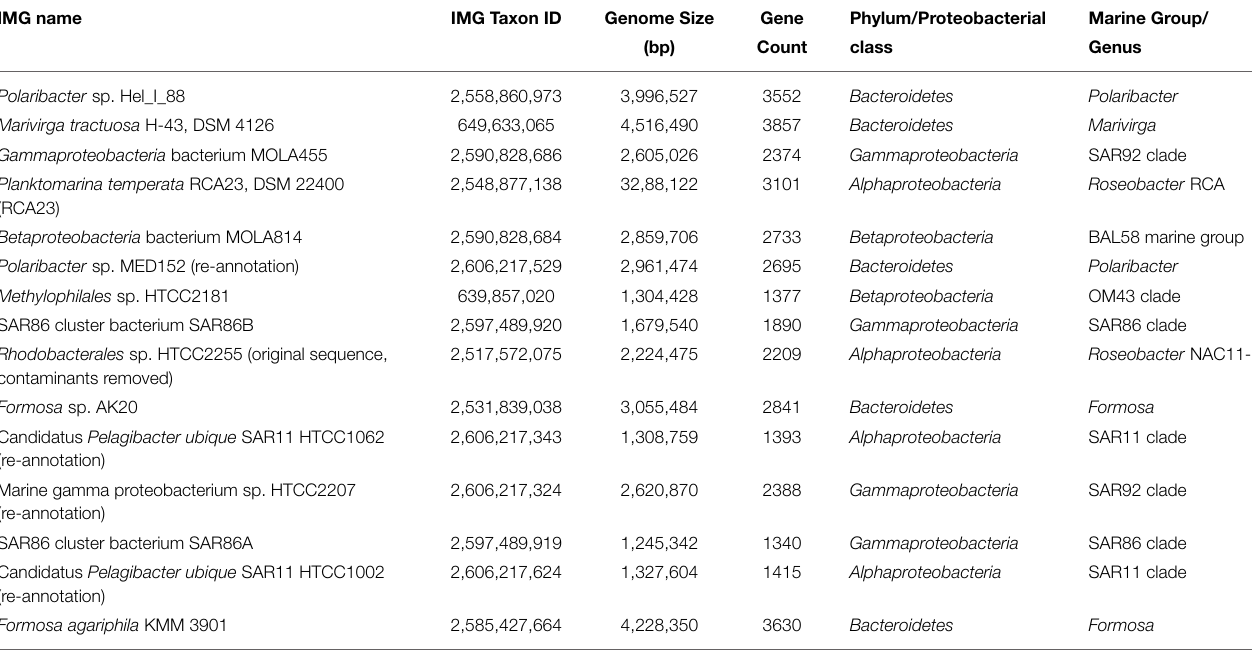
TABLE 4 | Genomes retrieved from the Integrated Microbial Genomes (IMG) database.